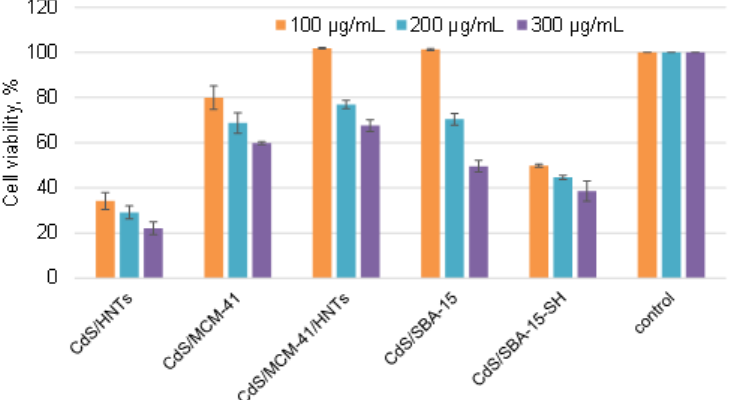
Figure 7. A549 cells metabolic activity analyzed using MTT assay after treatment with increasing concentrations of composites Live/dead staining of A549 cells treated with samples.